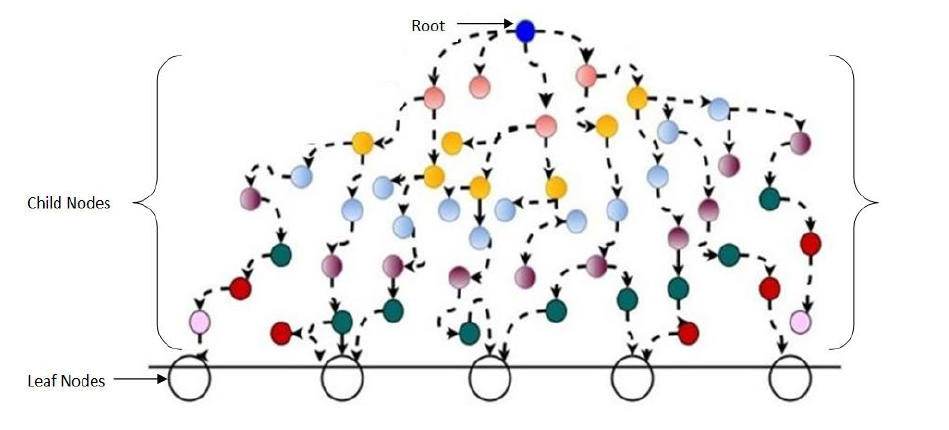
Figure 5. Tree Topology of Establishing Paths.